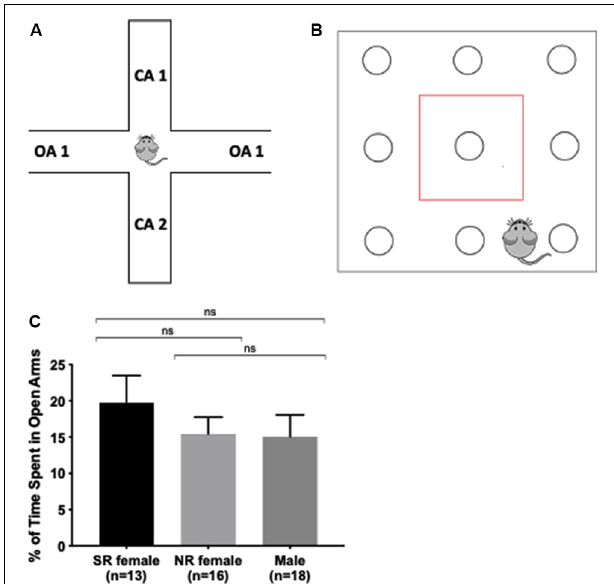
FIGURE 2 | Anxiety is not influenced by the estrus cycle. Apparatus for the elevated plus-maze. Mouse spends 5 min exploring two open arms without walls and two closed arms enclosed by walls. The more time spent in the open arms, the less anxiety and stress the mouse exhibits (A) . Apparatus for hole board. Mouse spends 15 min exploring a square arena containing exploratory holes for nose pokes. The more total time in, distance traveled in, and the number of entries into the center (enclosed in the red box), the less anxious the mouse. The more basic movements, rearing, and the number of pokes indicate greater exploratory behavior (B) . There was no significant difference between the female and male groups in the percent (%) of time spent in the open arms (C) . ns >